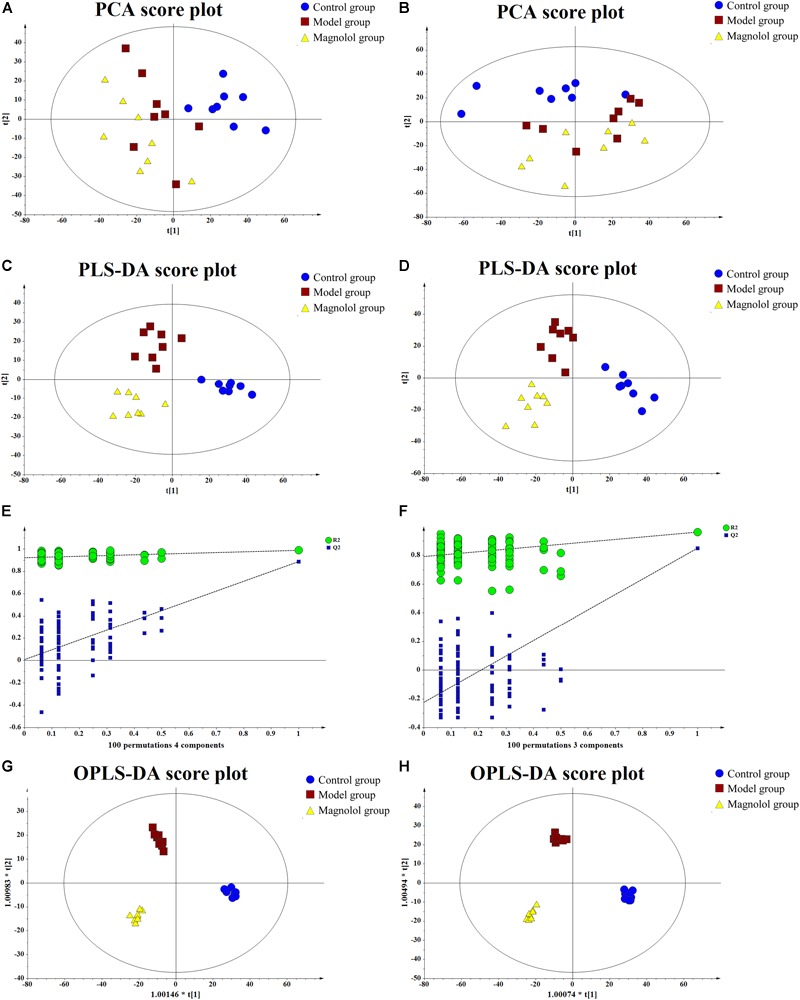
The results of multivariate statistical analysis. (A) The PCA score plot at positive ion mode. (B) The PCA score plot at negative ion mode. (C) The PLS-DA score plot at positive ion mode. (D) PLS-DA score plot at negative ion mode. (E) Permutations plot at positive ion mode. (F) Permutations plot at negative ion mode. (G) The OPLS-DA score plot at positive ion mode. (H) The OPLS-DA score plot at negative ion mode.